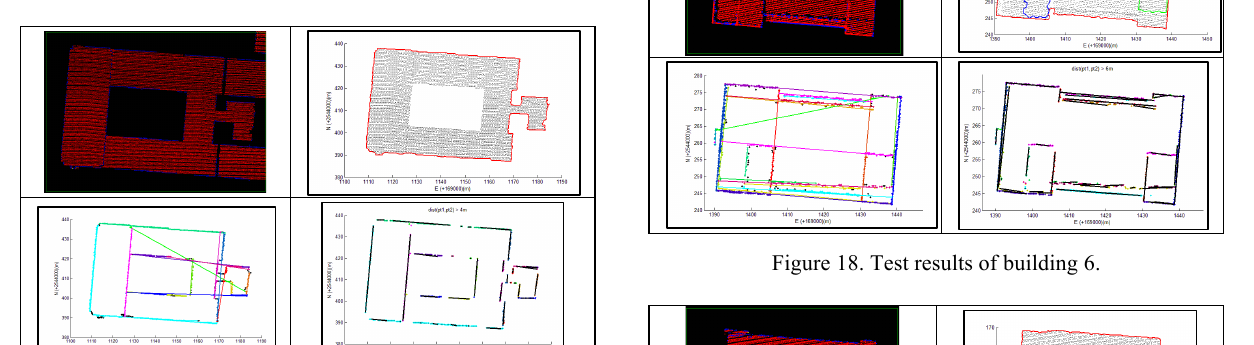
Figure 14. Test results of building 2.